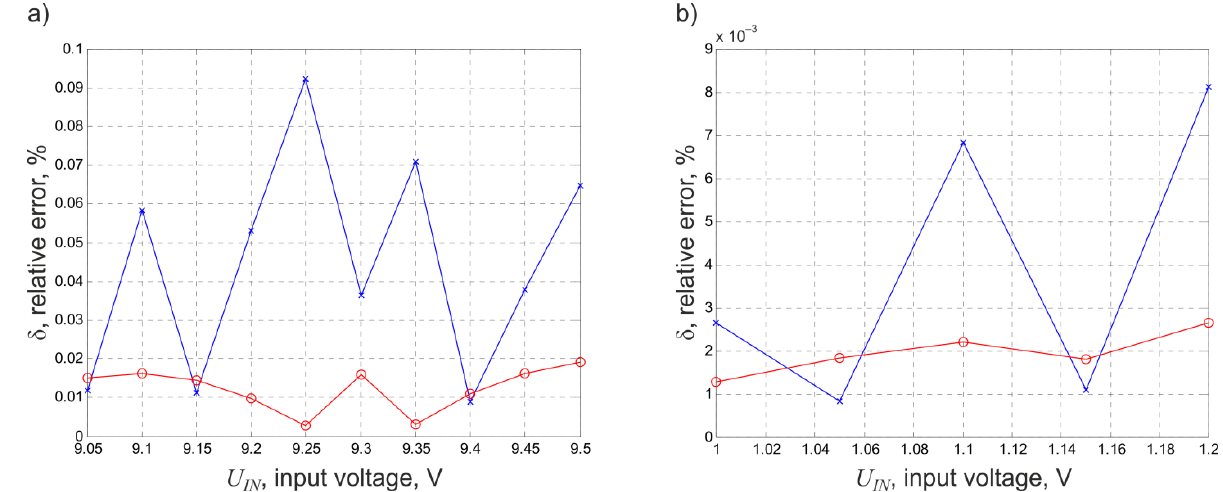
Figure 6. Graphs of the relative processing error of the multifunctional ADCF converter for 10 input voltages and set errors of 0.1% (blue x) and 0.025% (red o): ( a ) for the upper part of the operating range; ( b ) for the lower part of the operating range.